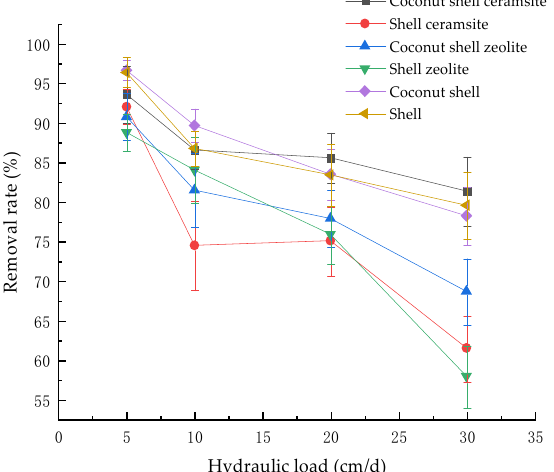
Figure 9. Removal effect of biochar-constructed wetland on total nitrogen.